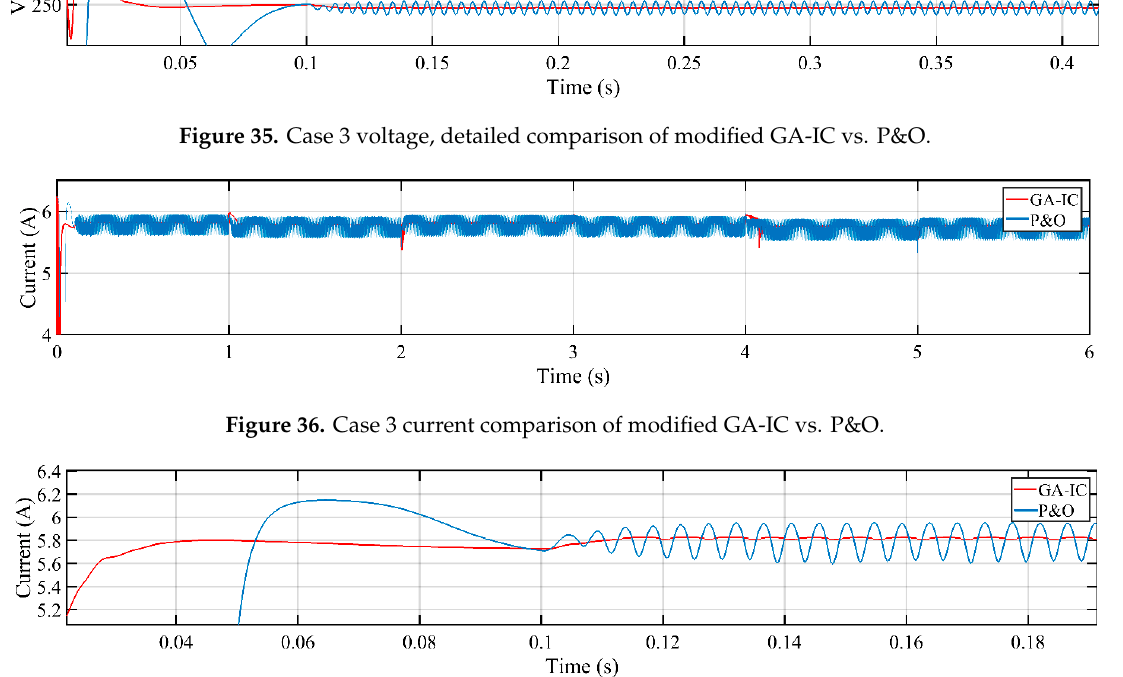
Figure 37. Case 3 current, detailed comparison of modified GA-IC vs. P&O.